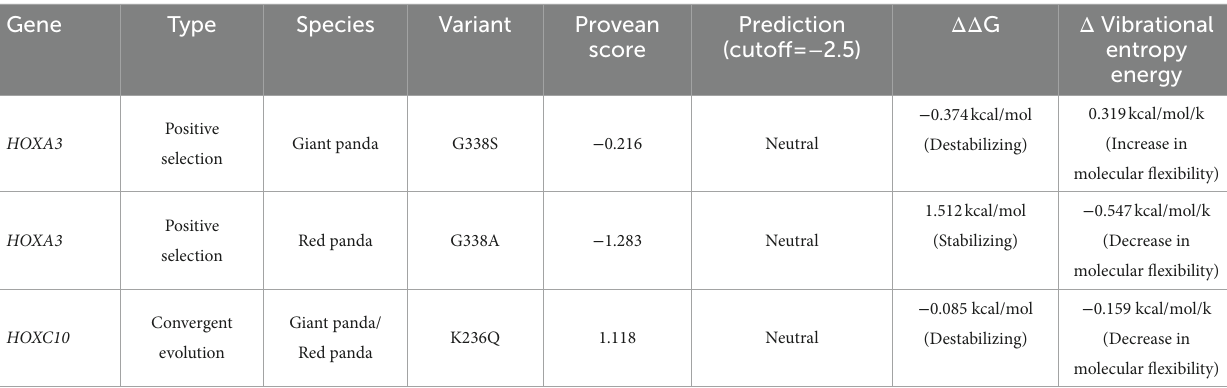
TABLE 3 Predicted effects for variants of two HOX